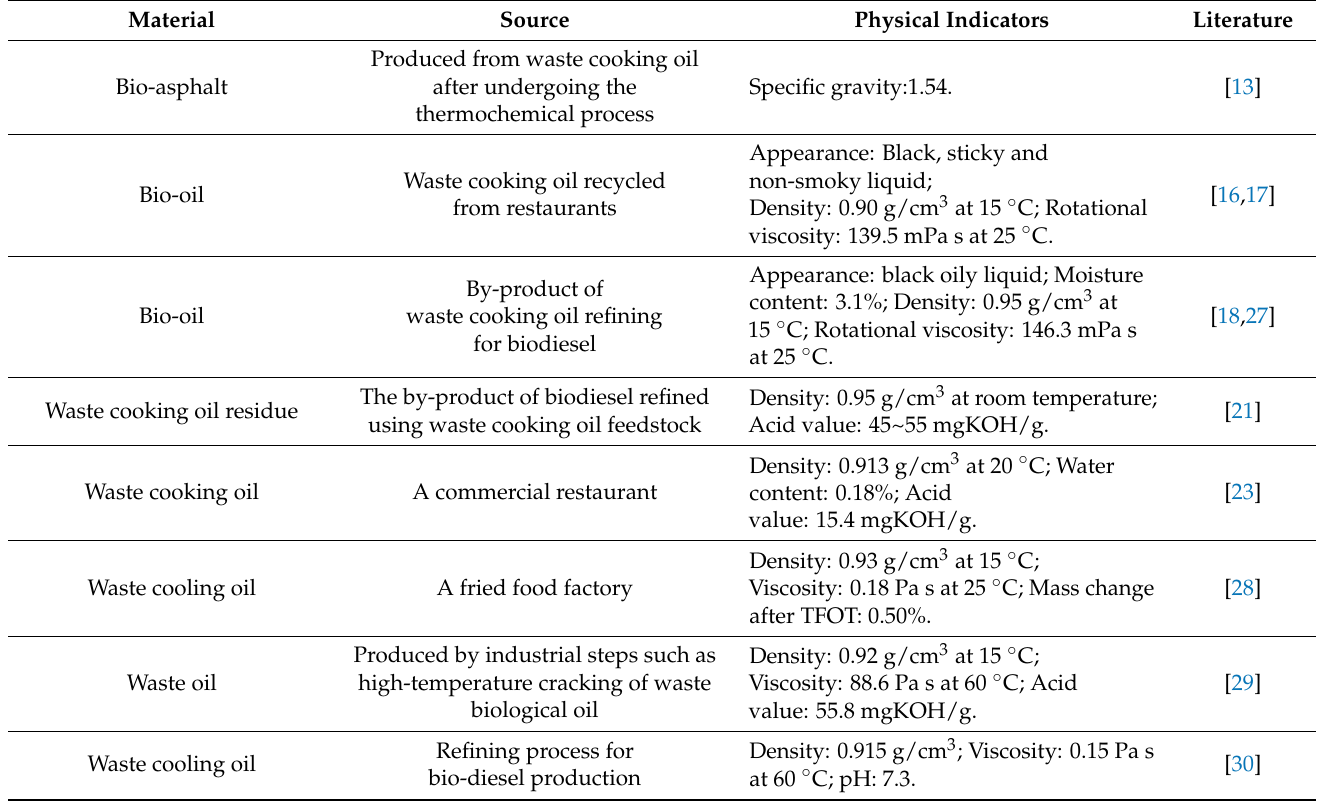
Table 2. Physical property of some waste cooking